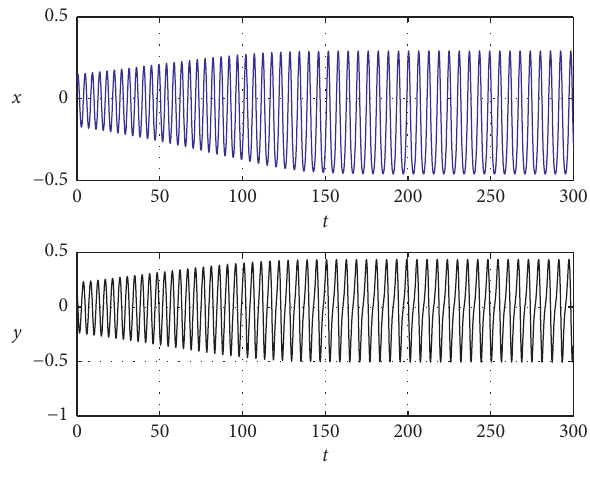
Figure 4: Waveform plot of system (7) near ( d , τ ) � (− 2 . 902 , 0 . 344 ) with parameters ( μ 0 0 0 . 026 ) , τ � 0 . 37, tspan � [ 0 , 300 ] , and ( x